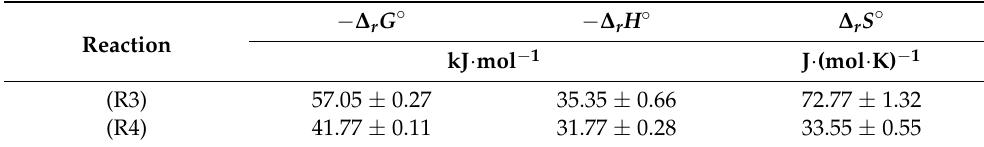
Table 7. Standard thermodynamic quantities of reactions (R3) and (R4) in the ECCs.